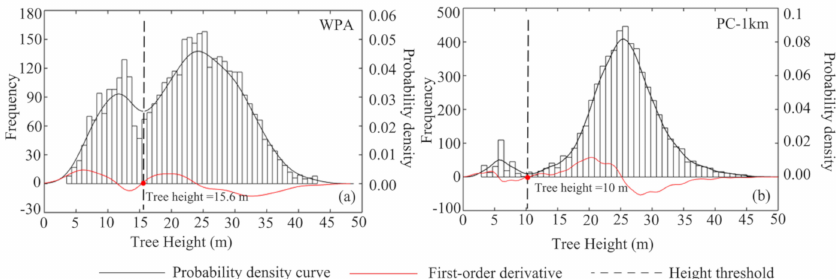
Figure 2. The histograms of ALS-based individual tree height frequency in both WPA (a) and PC (b) sites. The fitted probability density function curves (solid black lines) of individual tree height frequency and their corresponding first-order derivation solid curves (red solid lines) used to determine the height threshold (red dots) of forest vertical